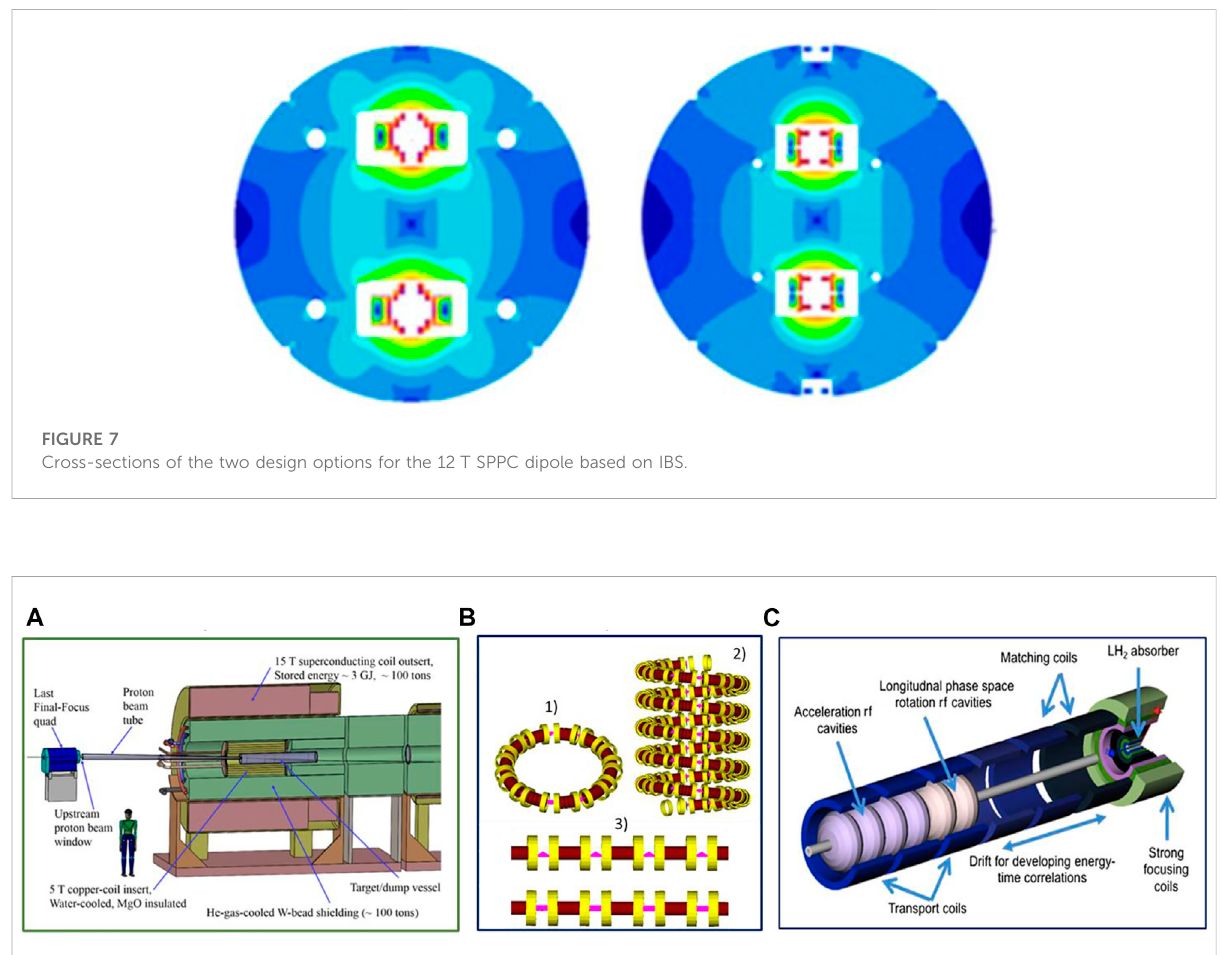
FIGURE 8 MCsolenoidconcepts: (A) muonproductionsolenoid; (B) variouspossiblesolenoidcon fi gurationsin6Dmuoncoolingsystem; (C) fi nalcooling system with high- fi eld